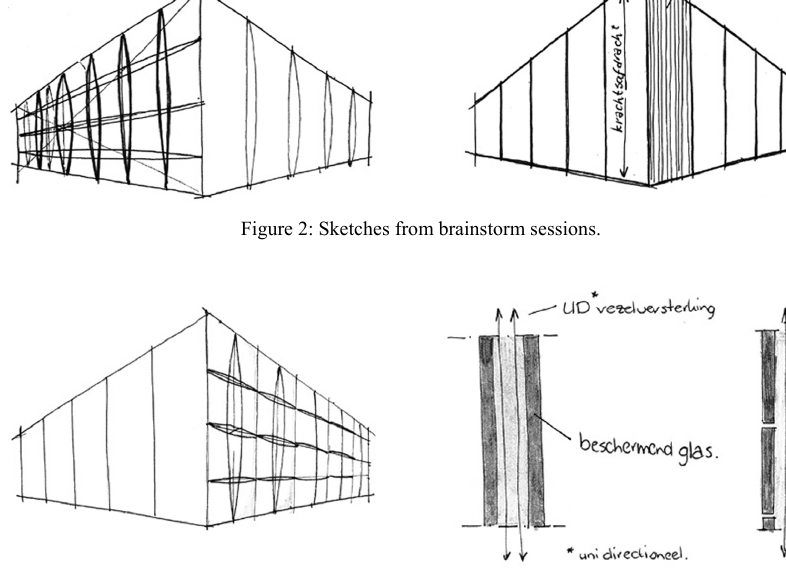
Figure 3 and 4: Sketches from the brainstorm